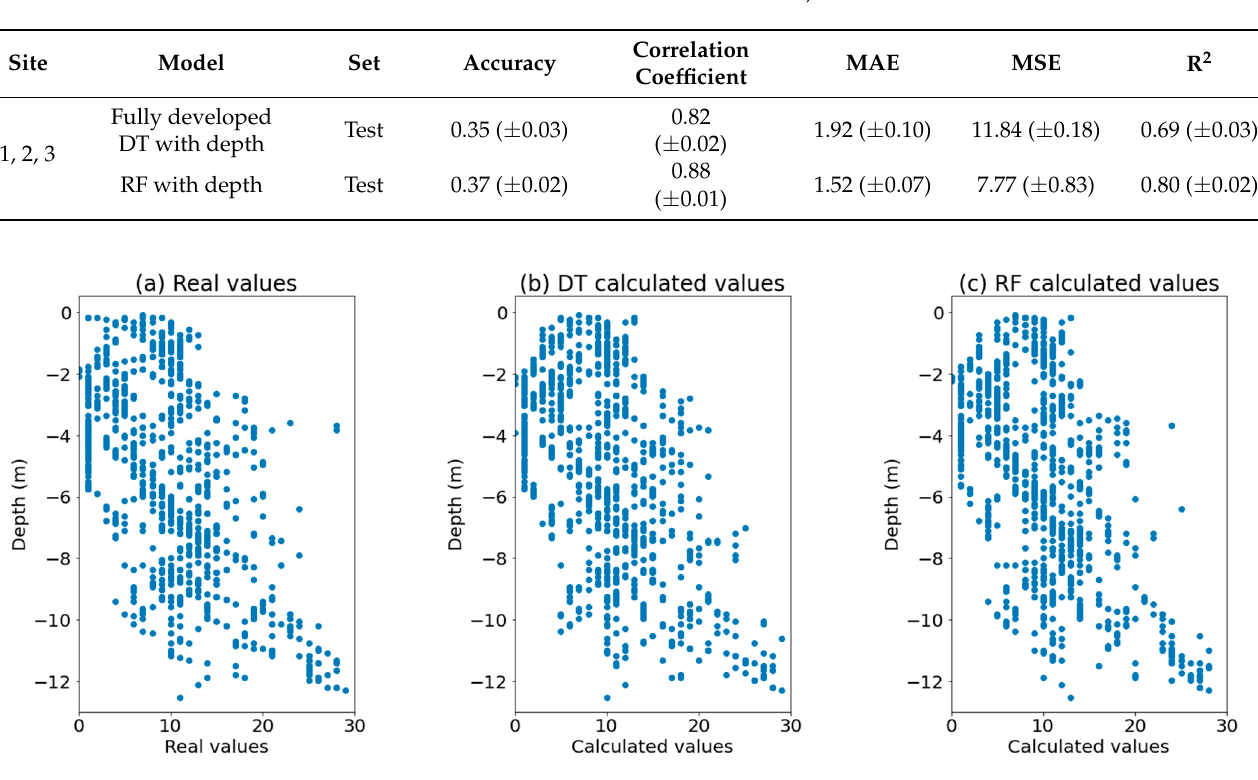
Figure 20. Real and calculated values for site 1, 2 and 3 considering depth. ( a ) Real values. ( b ) Values calculated by DT. ( c ) Values calculated using RF.